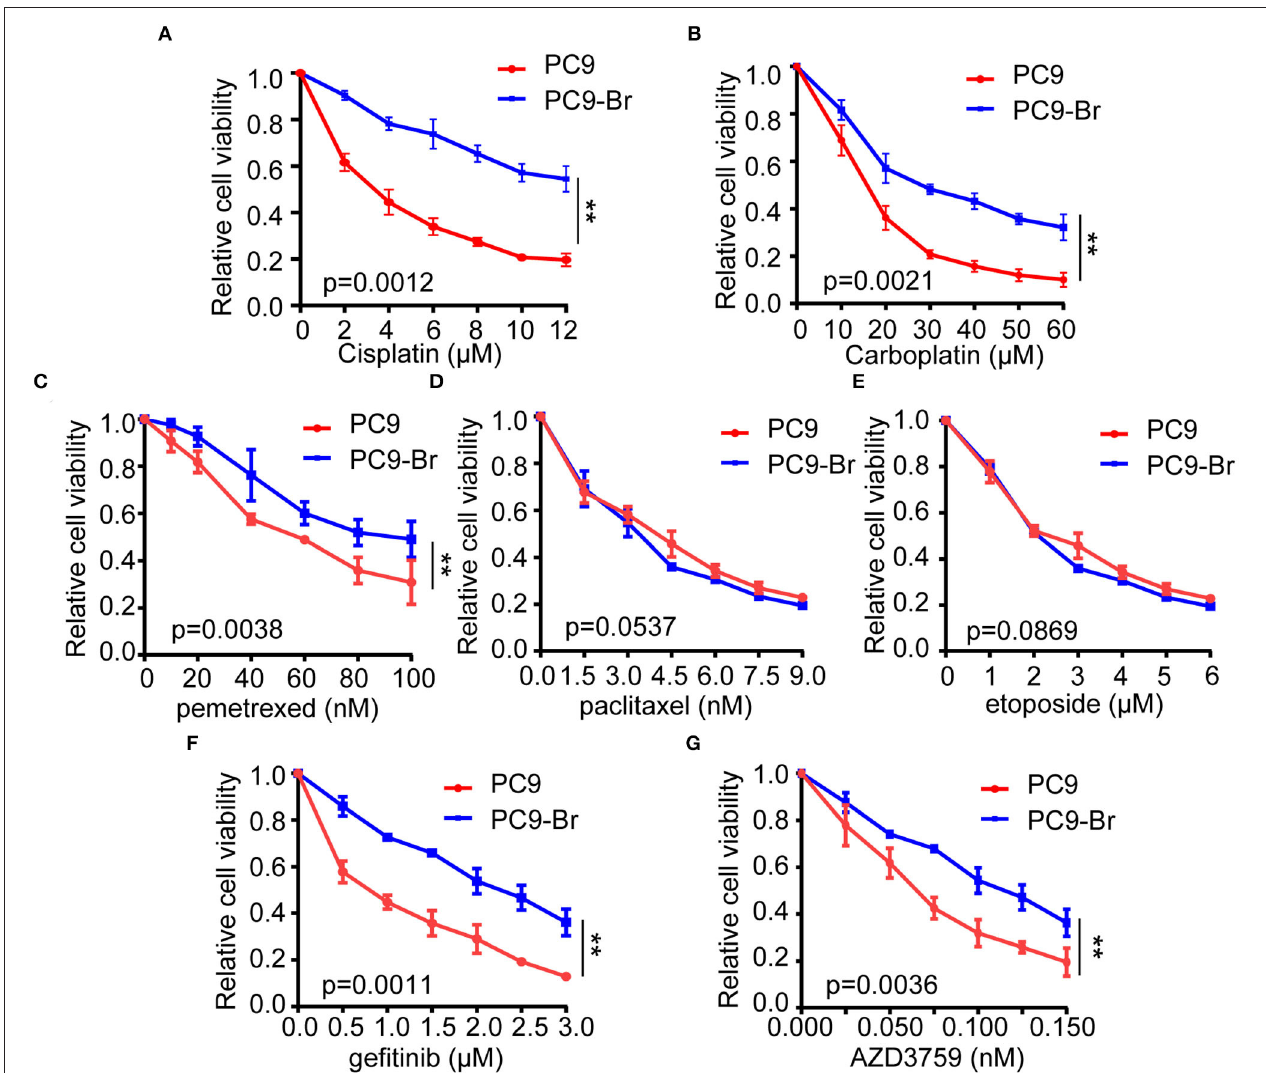
FIGURE 2 | The acquirement of obvious resistance to multiple anti-tumor drugs was found in PC9-Br cells. PC9 and PC9-Br cells were treated with different doses of cisplatin (A) , carboplatin (B) , pemetrexed (C) , paclitaxel (D) , etoposide (E) , gefitinib (F) , and AZD3759 (G) for 72h and CCK-8 assays were performed to determine their viability. n = 3, ** p <